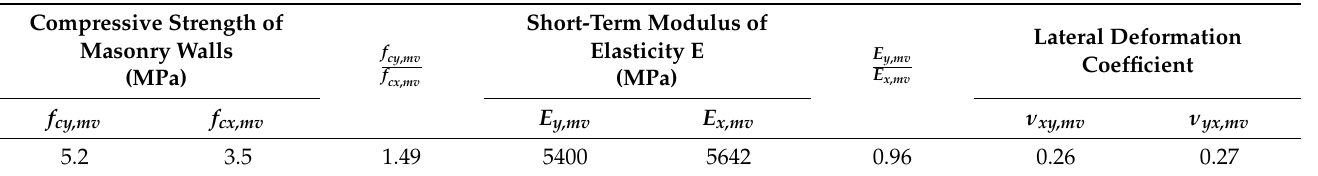
Table 4. Characteristic values of strength and deformation properties of the tested wall samples under compression along horizontal ( x ) and vertical ( y ) directions.